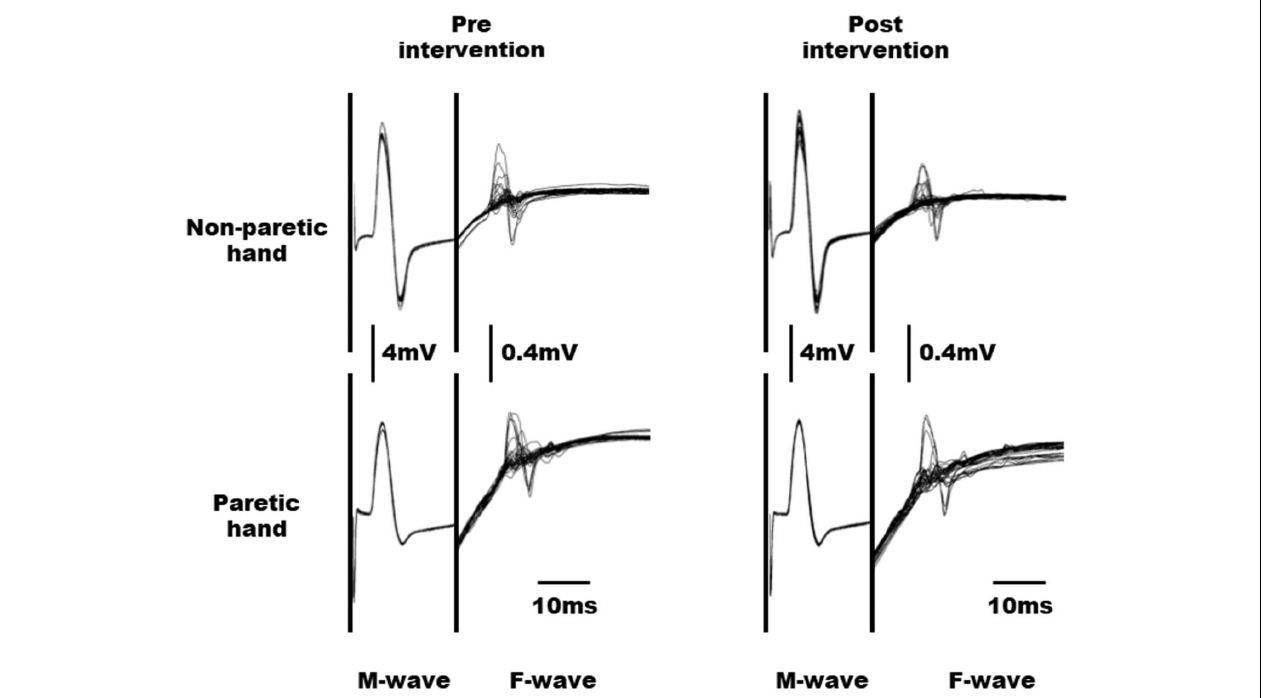
FIGURE 3 | Raw waveforms of M and F waves obtained from the non-paretic and paretic hands in a representative subject before and after intervention.